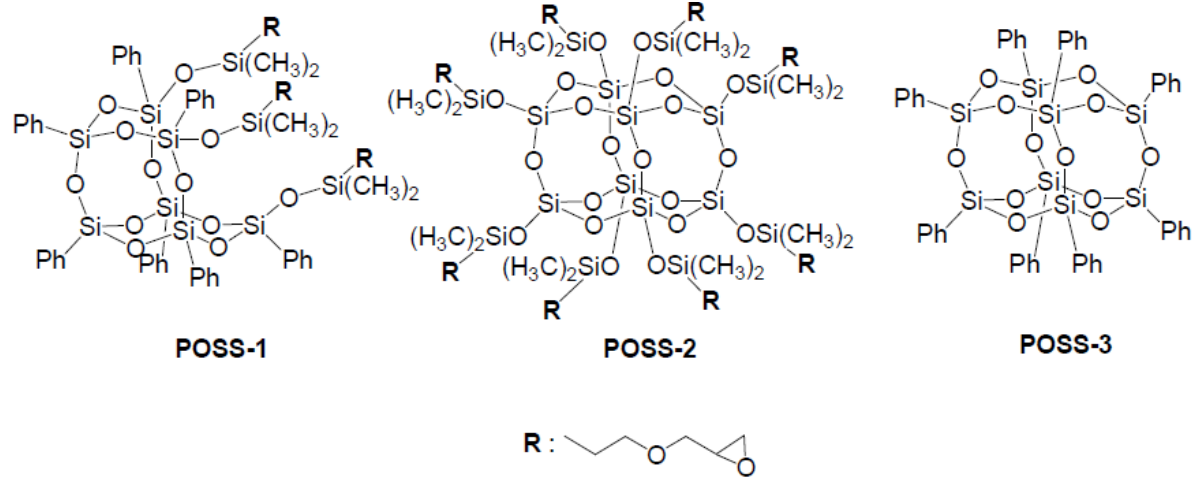
Figure 1. Structure of POSS used in this